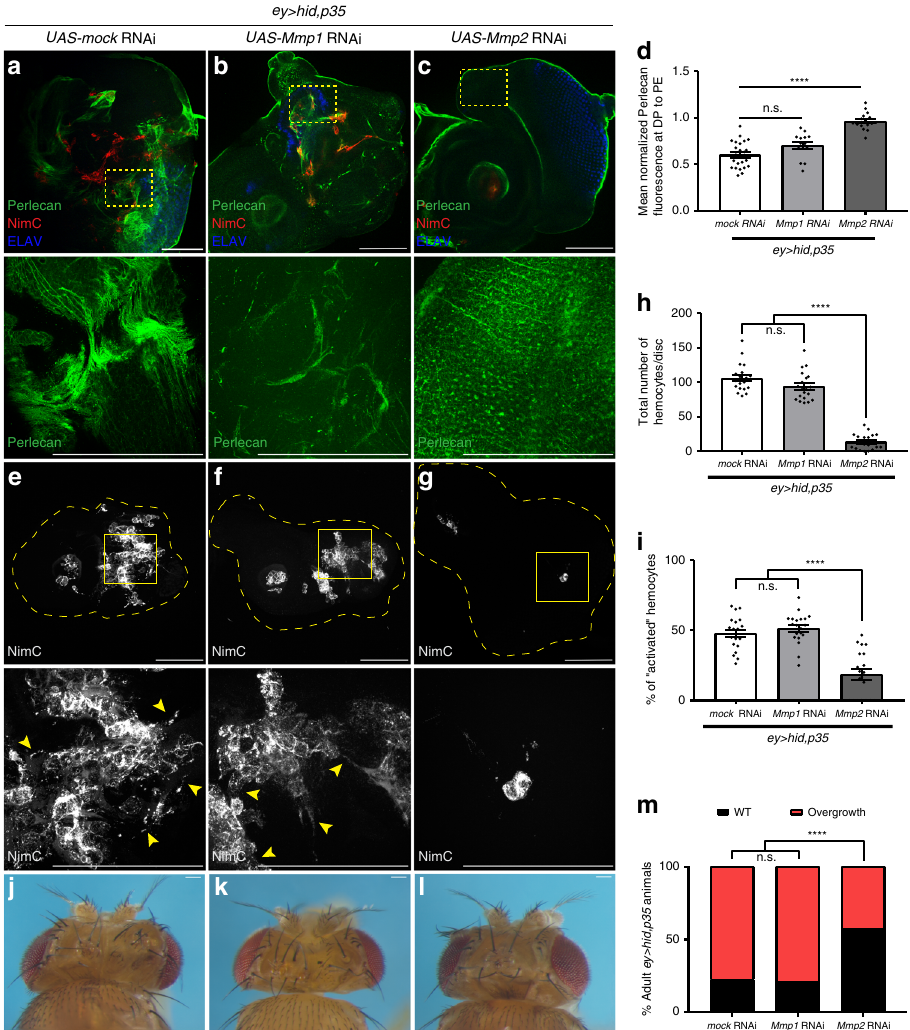
Fig. 5 Mmp2, not Mmp1, is required for BM damage, hemocyte recruitment and AiP. For all panels, scale bars 100 μ m. **** p < 0.0001, n.s. = no statistical signi fi cance. a – c Single slices focused on the basal side of DP show uniform Perlecan labeling in Mmp2 RNAi discs ( c ), while Mmp1 RNAi discs ( b ) still show irregularities as in mock ( RFP ) RNAi discs ( a ). d Quanti fi cation of Perlecan intensity in ( a – c ) taken from single slices at the basal surface of DP and normalized to PE, represented as mean fl uorescence ± SEM analyzed by one-way ANOVA with Holm – Sidak test for multiple comparisons. n = 26 ( mock RNAi), 14 ( Mmp1 RNAi), 16 ( Mmp2 RNAi) discs analyzed from three independent experiments. e – g Recruitment and activation of hemocytes (NimC in gray) to ey > hid,p35 discs is severely impaired upon knockdown of Mmp2 ( g ), while Mmp1 RNAi does not affect hemocyte recruitment ( f ) similar to mock RNAi discs ( e ). Yellow squares are magni fi ed below. Yellow arrowheads (bottom) indicate activated morphology of hemocytes. h, i Quanti fi cation of hemocyte recruitment ( h ) and activation ( i ) in ey > hid,p35 discs compared with Mmp1 and Mmp2 knockdown. Hemocyte activation was measured by the percentage of total hemocytes that had one or more cellular protrusions. Total number and percentage of activated hemocytes were analyzed by one-way ANOVA with Tukey ’ s multiple comparisons test. n = 20 discs per genotype analyzed in three independent experiments. j – l Mmp2 knockdown suppresses adult overgrowth. Representative images of adult heads of ey > hid,p35 animals that are expressing either mock ( RFP ) RNAi ( j ), Mmp1 RNAi ( k ), or Mmp2 RNAi ( l ). Mmp2 RNAi also suppresses larval imaginal disc overgrowth, as seen in c ) and ( g , where the disc morphology is restored, in contrast to ey > hid, p35 discs in a and e . m Quanti fi cation of the suppression of adult ey > hid,p35 overgrowth by Mmp2 RNAi. Progeny was scored as wild type (WT) (black bars) or overgrown (red bars). Suppression is measured by a shift in percentage to WT from overgrown animals that is signi fi cantly different as determined by two-sided Fisher ’ s exact test. n = 100 to 150 fl ies counted per genotype from four independent experiments. Source data are provided as a Source Data fi